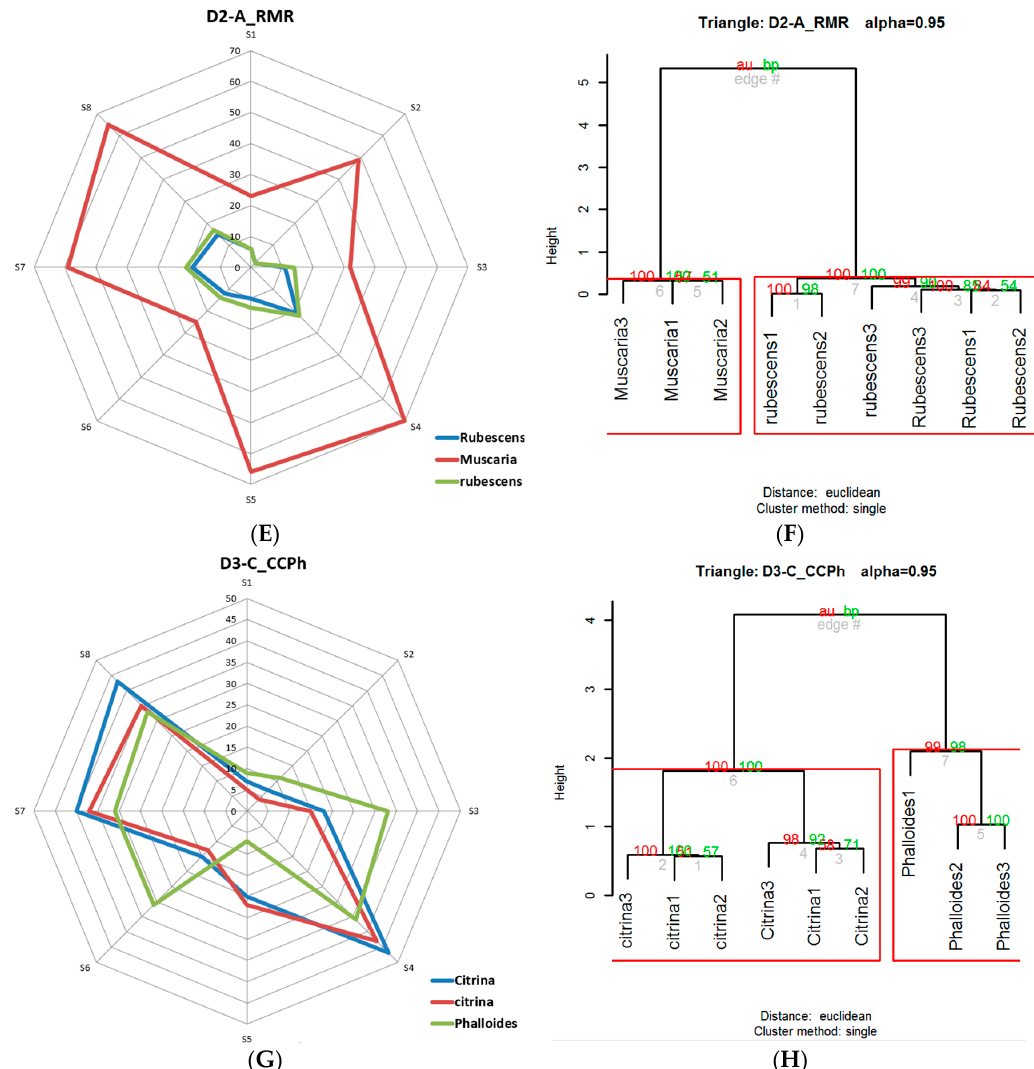
Figure 8. Odor fingerprints and dendrograms of the triangles: D1-A_MPP ( A ) ( B ), D1-C_PhCaPh ( C , D ), D2-A_RMR ( E ) ( F ), and D3-C_CCPh ( G ) ( H ).